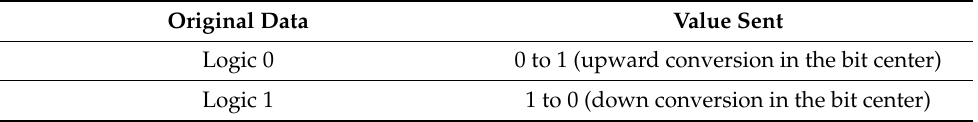
Table A1. The rules of Manchester